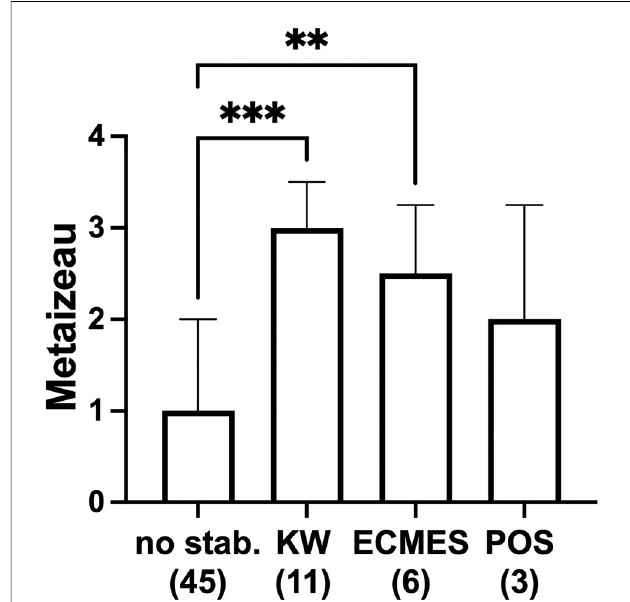
FIGURE 3 Metaizeau type with regard to treatment strategy no stabilization (no stab. n =45, thereof 38 patients with no reduction, 4 patients with closed reduction, and 3 patients open reduction and no stabilization), KW (K- wire, n =11), ECMES (embrochage centromedullaire elastique stable, n = 6), or POS (plate osteosynthesis, n =3). ** p <0.001, *** p <0.0001, graphical presentation as median±interquartile